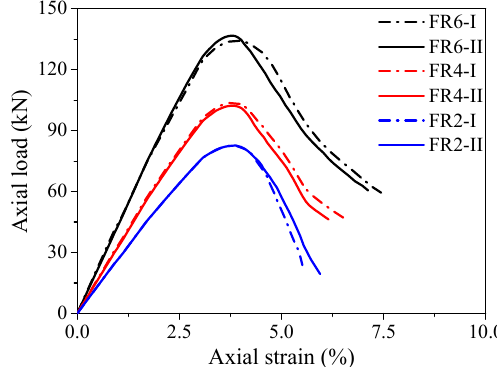
Figure 8. Axial load vs. strain responses of flax FRP rings.